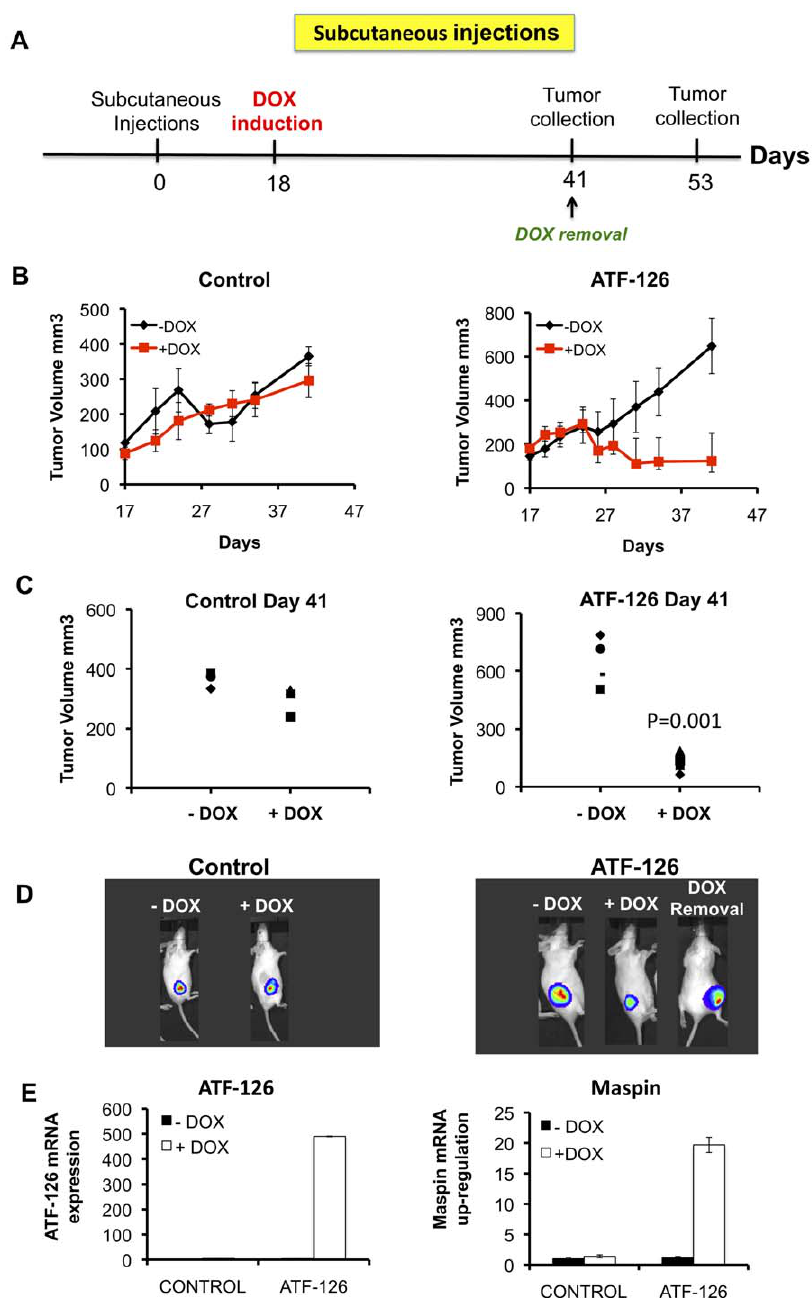
Figure 3. ATF-126 induced tumor suppression in SCID mice. A. Time-line of the experiments involving subcutaneous tumor injections illustrating the time of injection of tumor cells, induction and removal of DOX, and tumor collection. B. Time course plots monitoring tumor volumes of CONTROL and ATF-126 groups, N=8 animals per group. Four animals per group were maintained in DOX-free diet ( 2 DOX), whereas the other half was treated with DOX ( + DOX). The tumor growth was measured by caliper the day before induction (day 17) until tumor collection (day 41). C. Tumor volume measurements at the day of tumor collection for both CONTROL (left panel) and ATF-126 animals (right panel). Differences in tumor growth were calculated with a student t test (***p=0.001). D. Representative bioluminescence images comparing signal intensities of luciferase photon counts from the subcutaneous growths at day 41 for CONTROL (left) and ATF-126 animals (right), treated in absence ( 2 DOX) and presence ( + DOX) of DOX. ‘‘DOX removal’’ indicates an ATF-126-injected animal previously induced with DOX, subsequently removed from DOX (day 41), and imaged at day 53 (right). E. ATF-126 and Maspin expression levels by qRT-PCR in tumor samples collected at day 41 from both, CONTROL and ATF-126 animals.